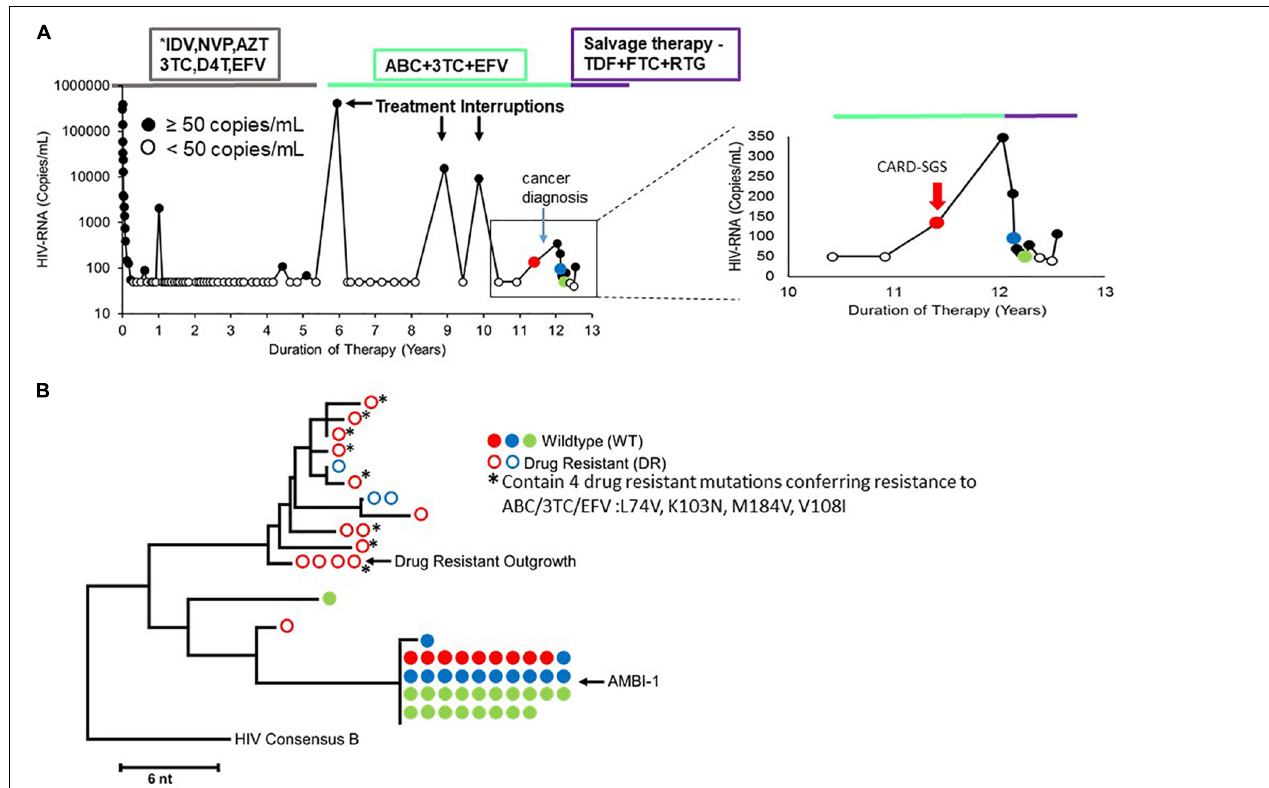
FIGURE 1 | (A) Longitudinal viral load plot of Patient 1 in Maldarelli et al. (2014) and Simonetti et al. (2016) from the time of ART initiation to his death from cancer. Viral loads below limit of detection ( < 50 copies per mL) are indicated with open black circles. The red arrow in the right panel indicates the timepoint that was analyzed by CARD-SGS (viral load of 134 copies/ml). (B) NJ tree showing plasma RNA sequences at three marked timepoints on the viral load plot in A. Solid circles indicate sequences with no drug resistance mutations and open circles indicate drug-resistant variants. The ART regimens employed are shown in the boxes at the top. ∗ Indicated that the drug regimen was simplifed for the